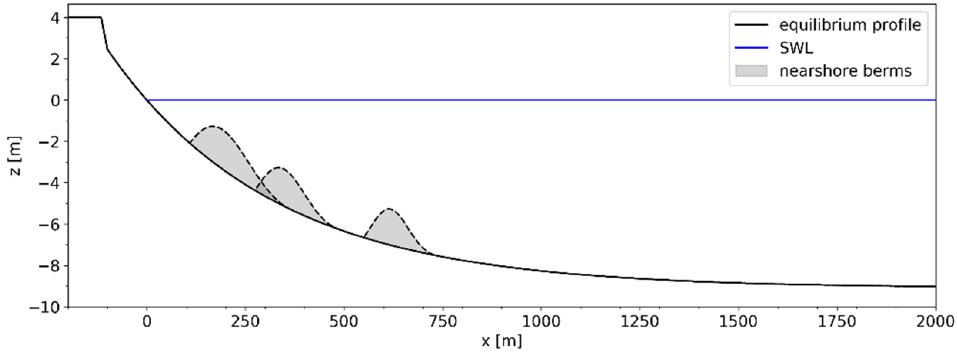
Figure 4. Cross-shore profile of SP linear berms.